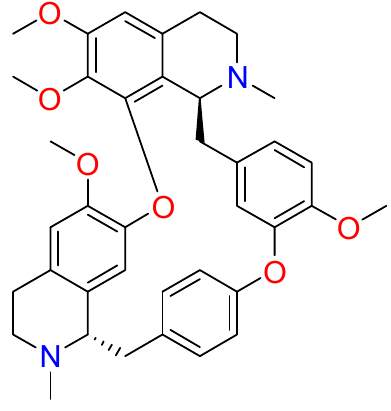
Figure 6. 2D structure of hanfangchin A (tetrandrine).